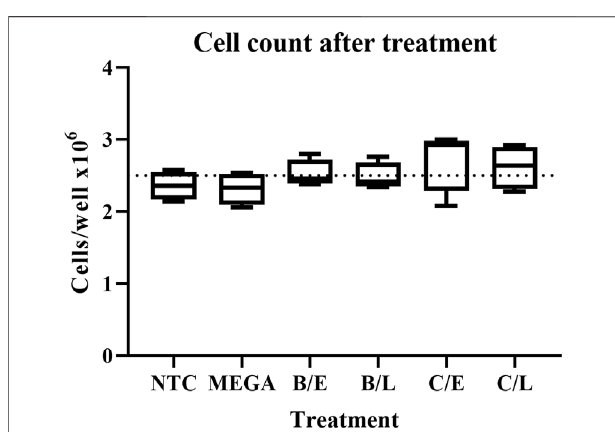
FIGURE6| Effectonadherence and growth ofRP- Hz GUT-AW1 cellsof transfection with dsRNA produced in vitro or in bacteria. Cells were placed in 24-well plates at > 95% viability and treated with 2.5 μ g/ml lipoplexed dsGFP or empty lipoplexes overnight. The transfection medium and loose cells werethen removed and replacedby complete cell medium. Thecells were left to grow for one more day, after which they were collected, and their concentration measured. Four replicates were tested for each condition. Boxplots with min to max whiskers. Dotted line indicates the seeding levels of the cells before treatment. No signi fi cant differences were observed ( p > 0.05) when applying one-way ANOVA analyses. NTC = no-template control consistingofemptylipoplexes;MEGA=dsRNAproduced invitro byusingthe MEGAscript kit; B = sonication pre-treatment; C = heating pre-treatment; E = RNase A digestion in NaCl buffer; L = LiCl